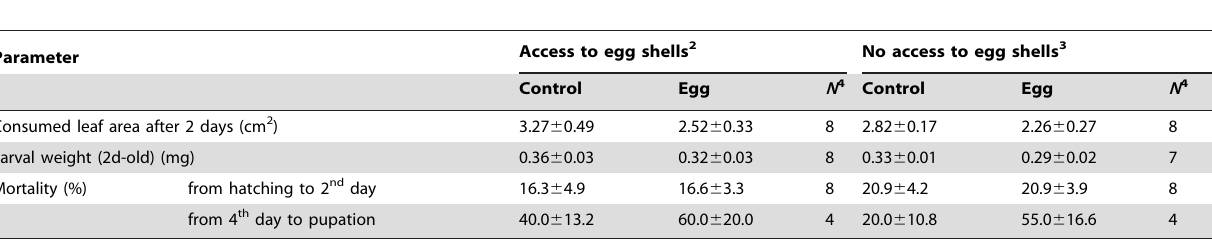
Table 1. Effects of prior egg deposition and egg shell consumption (a typical behaviour of neonate larvae) on larval performance (means 6 SE) of Pieris brassicae on Arabidopsis thaliana Col-0 plants 1 (for statistics, see Table 2).